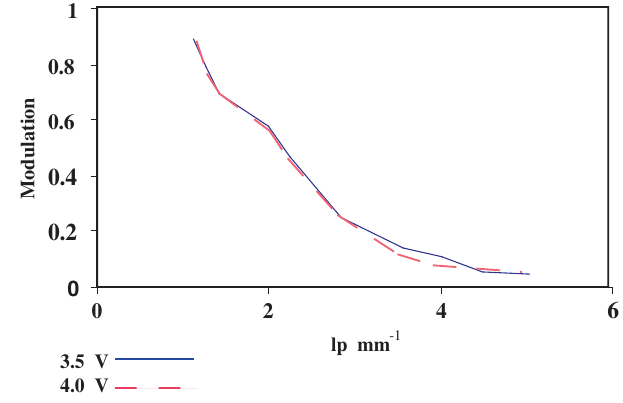
FIG. 4. (Color) MTF measurements of the horizontal optical setup for different MCP gains. The stability of the MTF is noteworthy. were performed to determine the limiting resolution while varying the intensifier gain. An example for two different gains is shown in Fig. 4 (lower applied voltages (cid:6) higher gain, see Fig. 10).